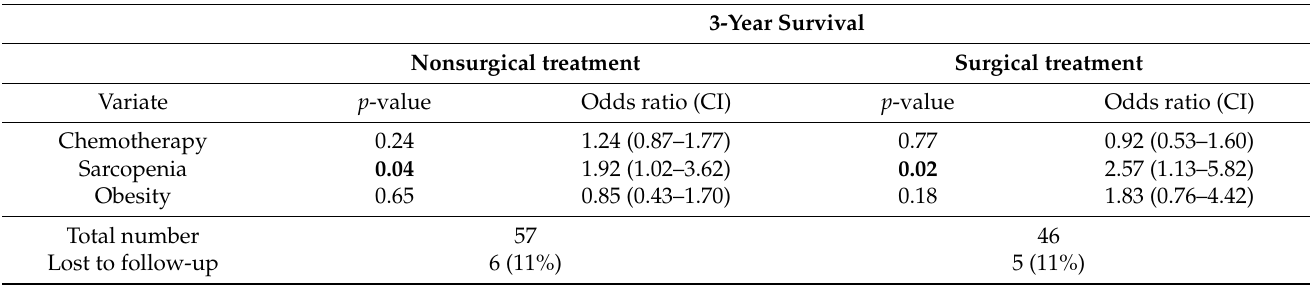
intelligence, CI = confidence